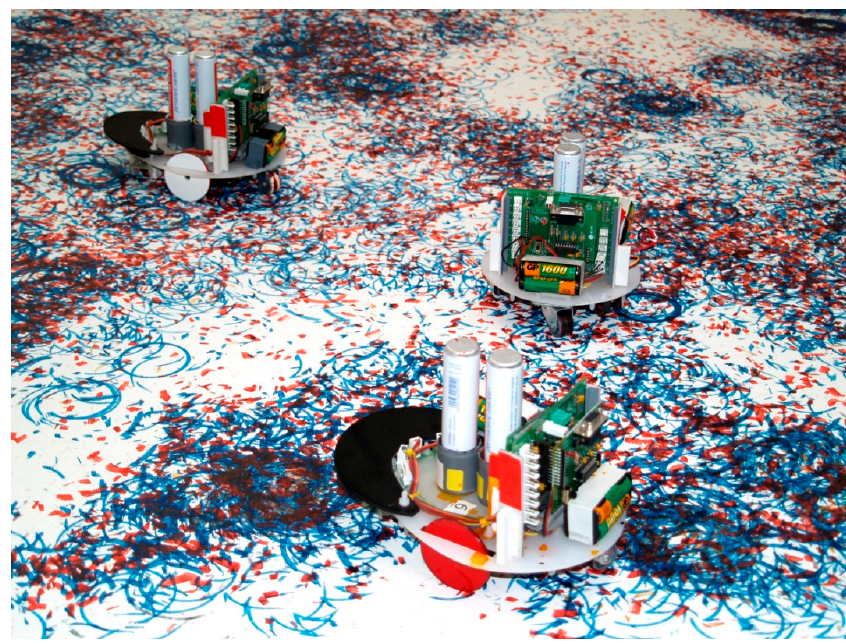
Figure 1. Three artbots at work. Photo ©2001 Robotarium and used by permission.